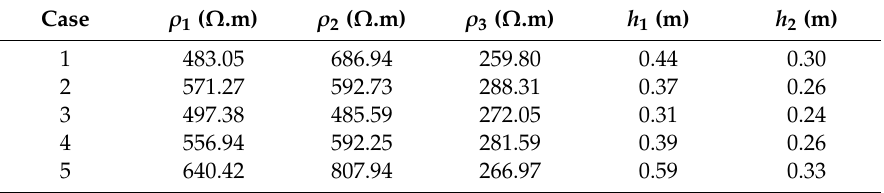
Table 3. Three-layer soil model parameters for the five combinations of resistivity measuring axes.